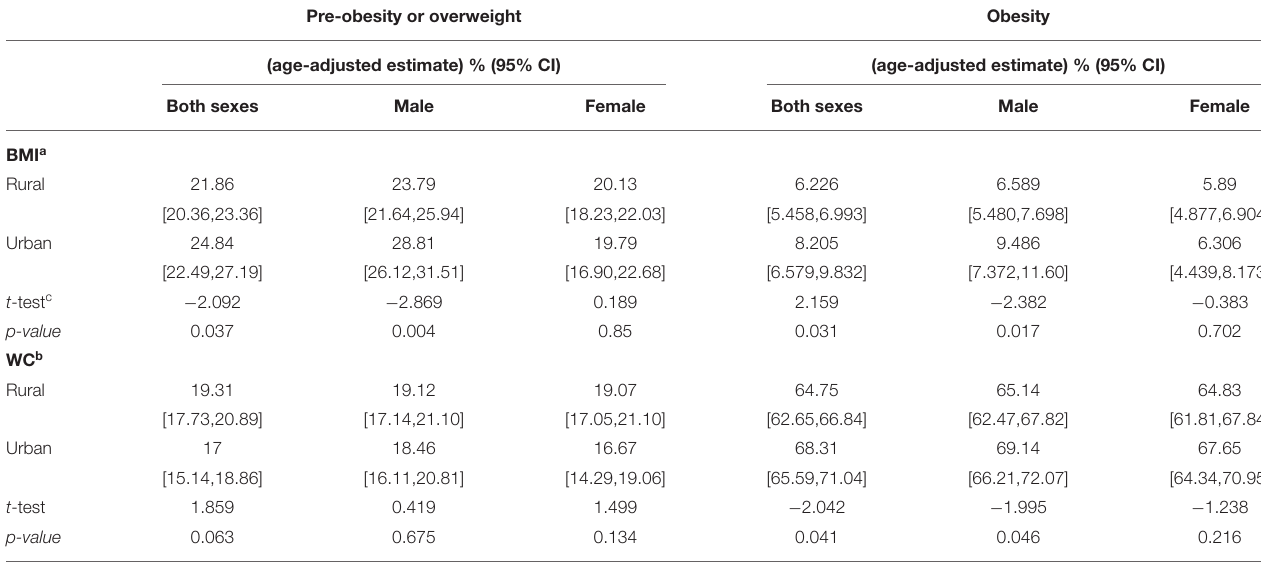
TABLE 2 | Prevalence of being overweight and of obesity among workers by